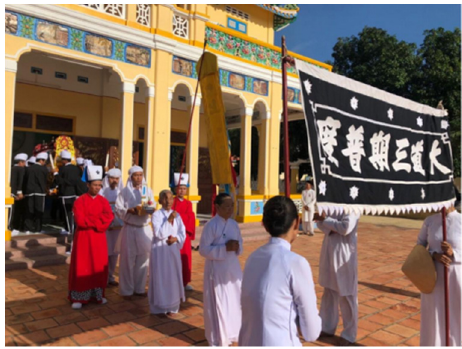
Figure 1. On the third morning, on the way to the cemetery, Tây Ninh, 2 July 2018 (© Shao Zhu